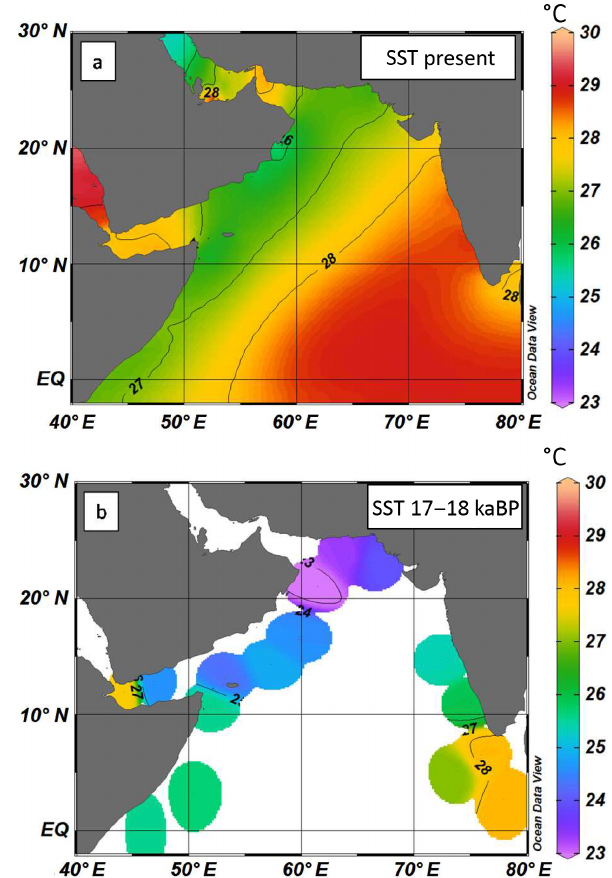
Figure 3. Millennial regional averages of SST ( ◦ C) and ± 1 σ stan- dard deviation in the northern, western, eastern, and southeastern Arabian Sea and the Oman and Somali upwelling areas of the last 25kyr. Regions are indicated in Fig. 1. Times of interstadial 2 (IS2), Heinrich Event 1 (H1), and Younger Dryas (YD) are indicated by grey bars. The last glacial maximum (LGM), early Holocene (EH), mid-Holocene (MH), and late Holocene (LH) are also marked. Lines mark the beginning of MH and LH.